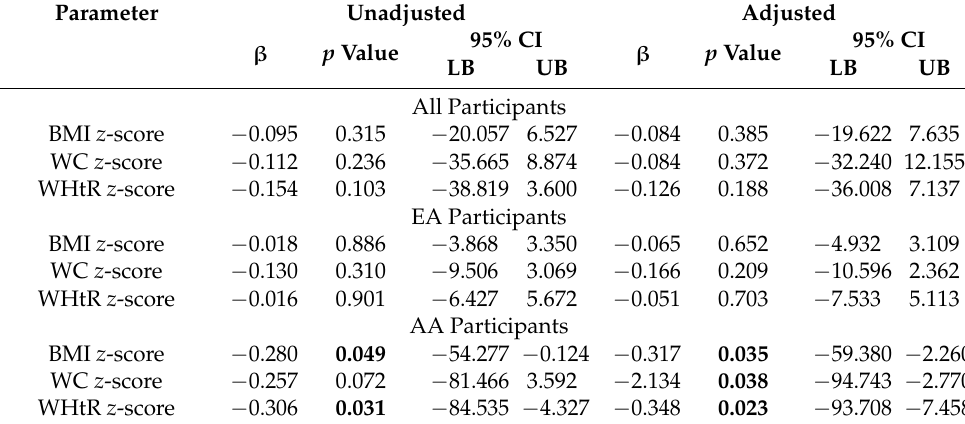
Table 7. Hierarchical regression analysis of obesity measures and PMR of LEPR . Parameter